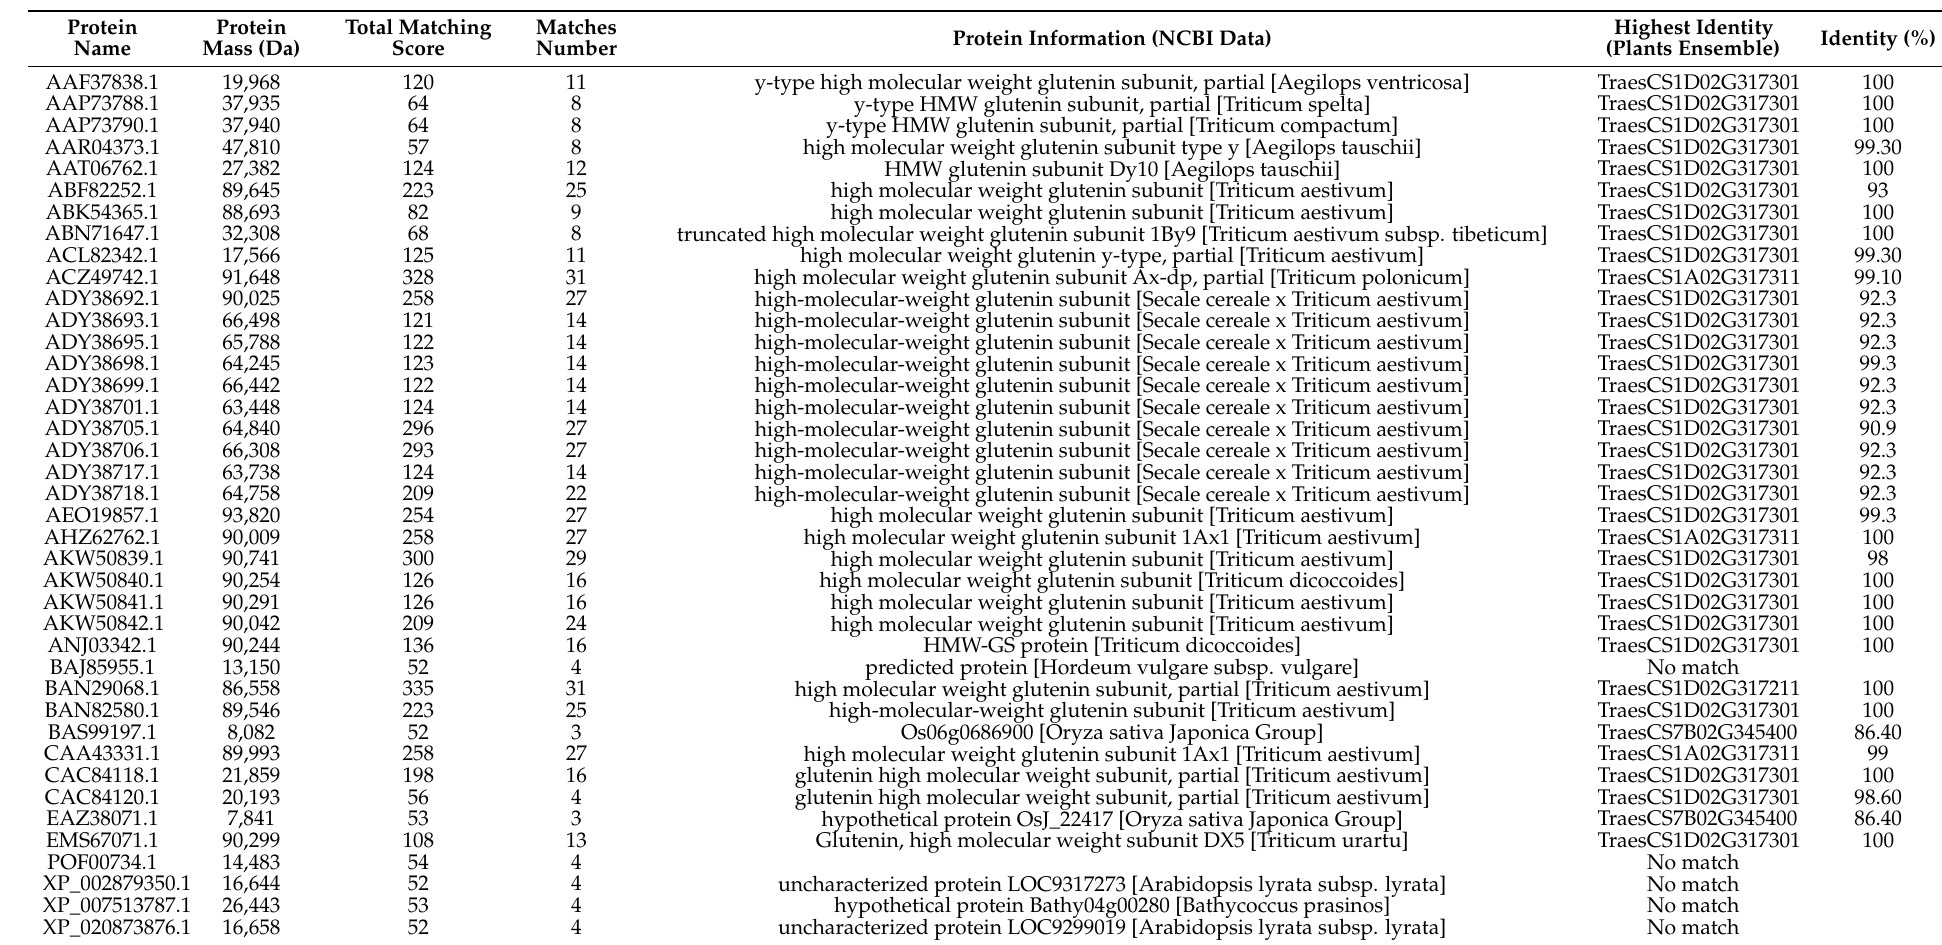
Table 1. Protein identification by MALDI-TOF mass spectrometry. Protein name, identification number (NCBI data); protein mass, the expected mass of a protein with a high-confidence identity match; total matching score, combined score of all observed mass spectra that can be matched to amino acid sequences; matches number, the number of MS/MS spectra matched to the protein; protein information, name of genes with significant alignment; highest identity, the highest percent identity between a set of aligned segments and the same subject sequence; identity (%), the percent of query length that is included in the aligned